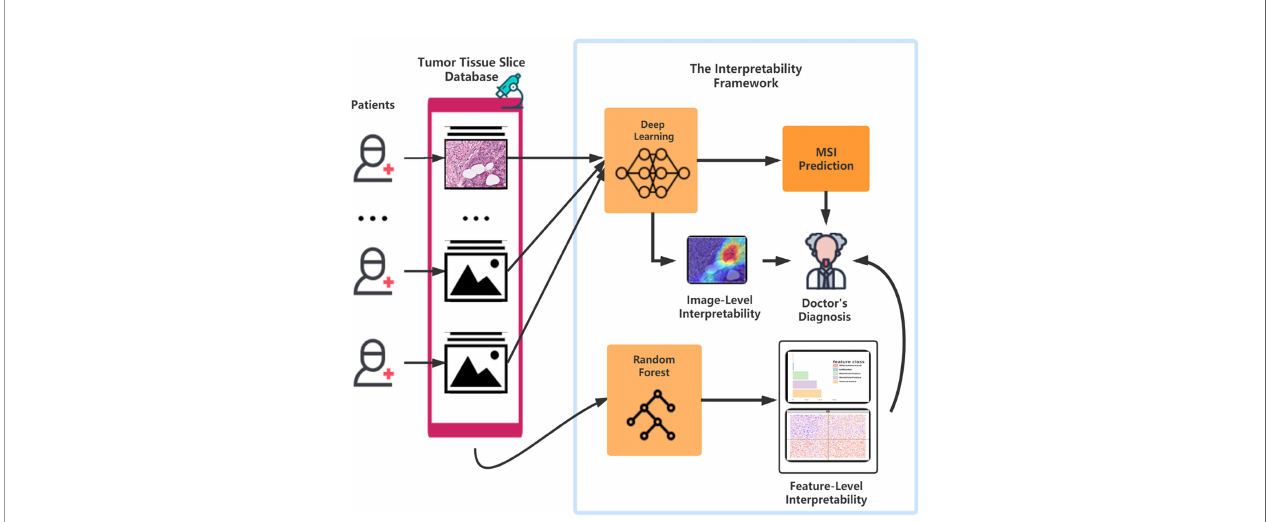
FIGURE 6 | The fl owchart of the pattern in which our framework can assist the doctor ’ s diagnosis. After surgery or biopsy, the embed cut H&E provided by each patient would go through MSI screening with deep learning. The doctor can make a critical diagnosis based on his insight combined with the prediction result and the deep learning model ’ s visualization. Meanwhile, with the amplifying of the H&E datasets, the random forest could develop a more precise and interpretable model, which helps the doctors detect